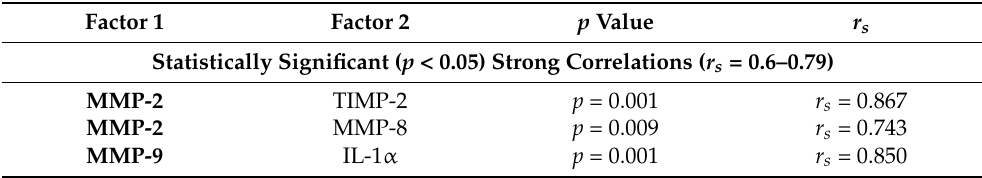
Table 6. An overview of the Spearman’s rank correlation analysis, conducted to identify the moderate and strong links between the number of positive factors in the control